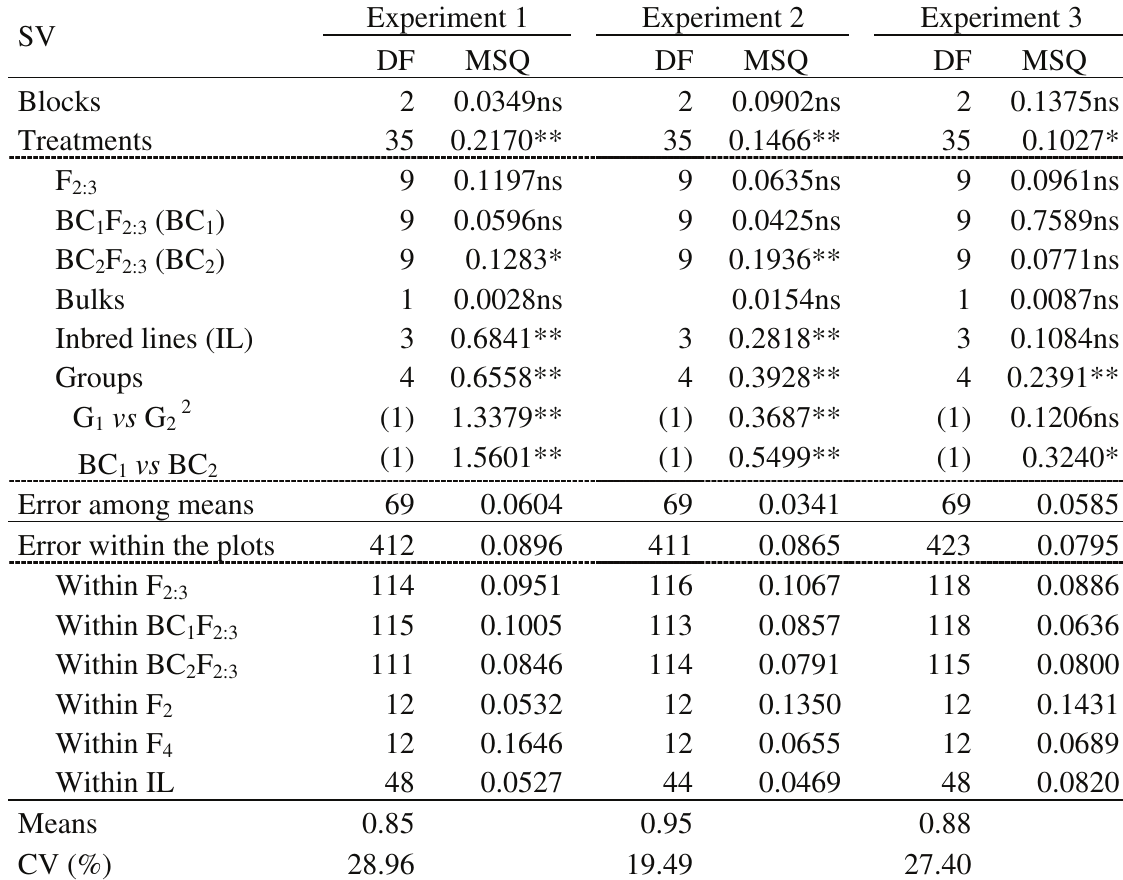
Table S6 - Summary of analysis of variance, with those mean squares associated to variation among the means and within the plots from their respective sources of variation for the trait percentage of spotted soybean seeds